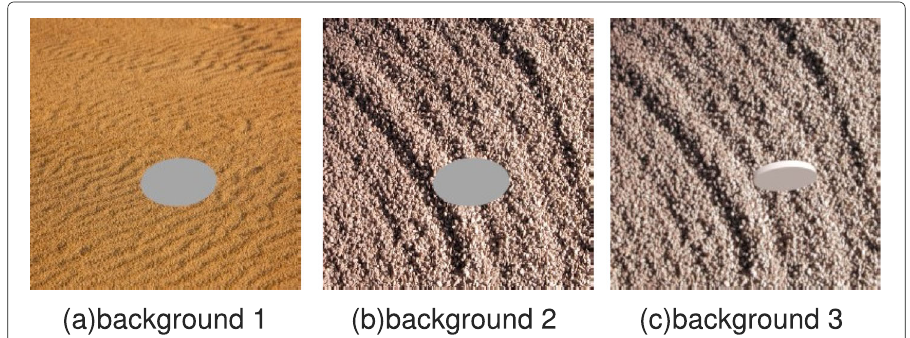
Fig. 4 Circular feature model of 3D object and cylindrical model is embedded into complex background. The parameters λ 1 , λ 2 , λ 3 for the three image sequences from left to right are [1,1,0.1],[1,1,1],[1,1,1], respectively. The parameters λ in , λ out for the three image sequences from left to right are [1.0e − 6,1.0e − 7],[8.0e − 6,2.0e − 7],[8.0e − 6,2.0e −